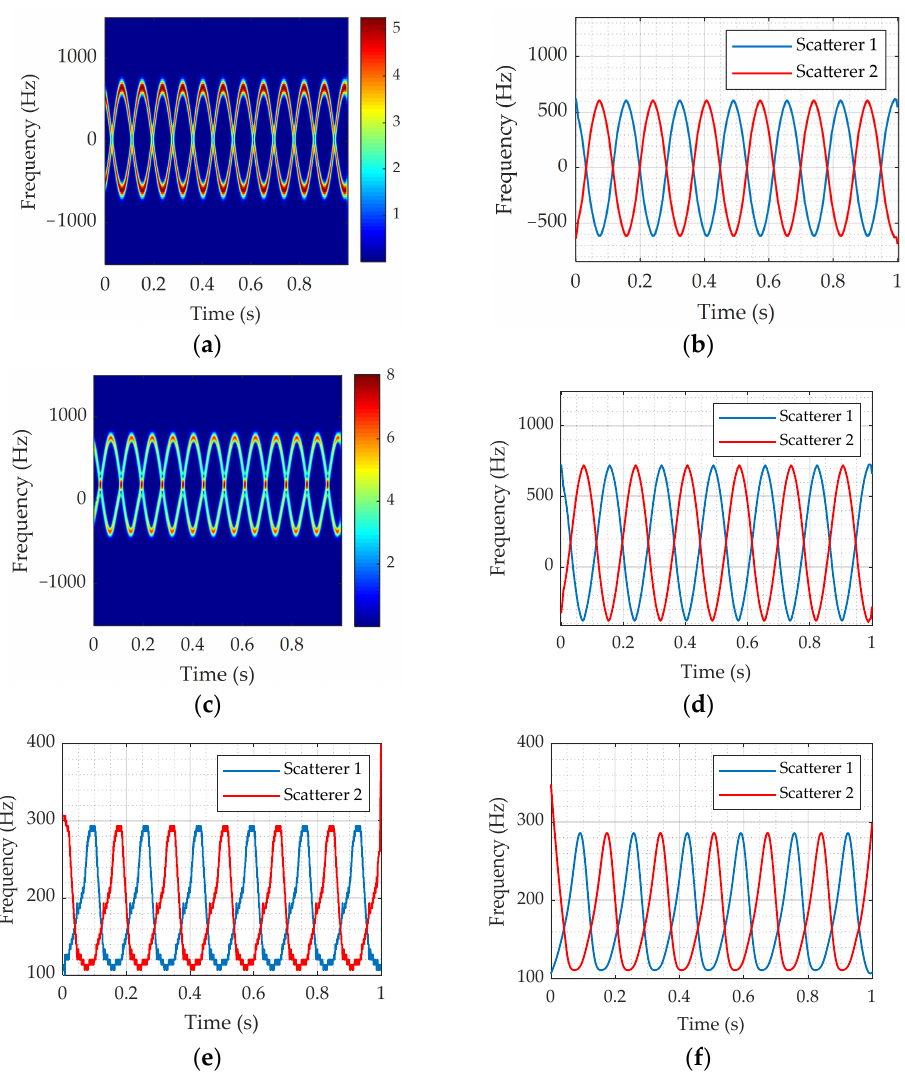
Figure 13. The micro-Doppler effect of the vortex-electromagnetic-wave-based radar. The STFT image of the linear micro-Doppler curve ( a ) and its curve separation result ( b ); The STFT image of the total micro-Doppler curve when l = 30 ( c ) and its curve separation result ( d ); The angular Doppler curve before smoothing ( e ) and after smoothing ( f ).